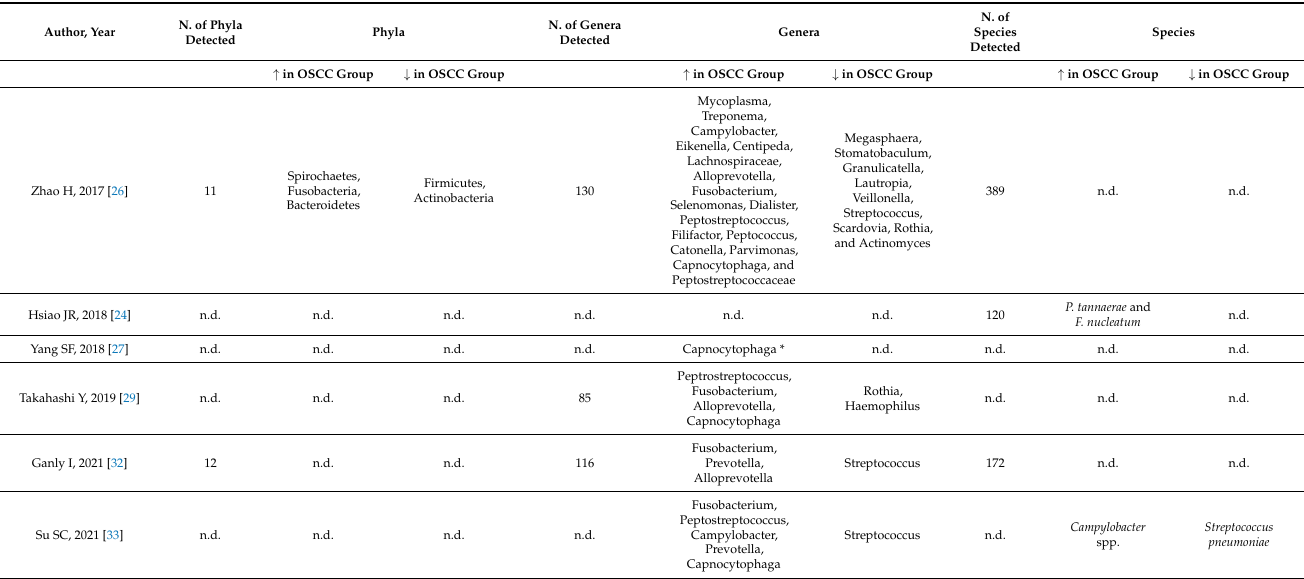
Table 2. Description of the statistically significant results about phyla, genera, and species of the studies